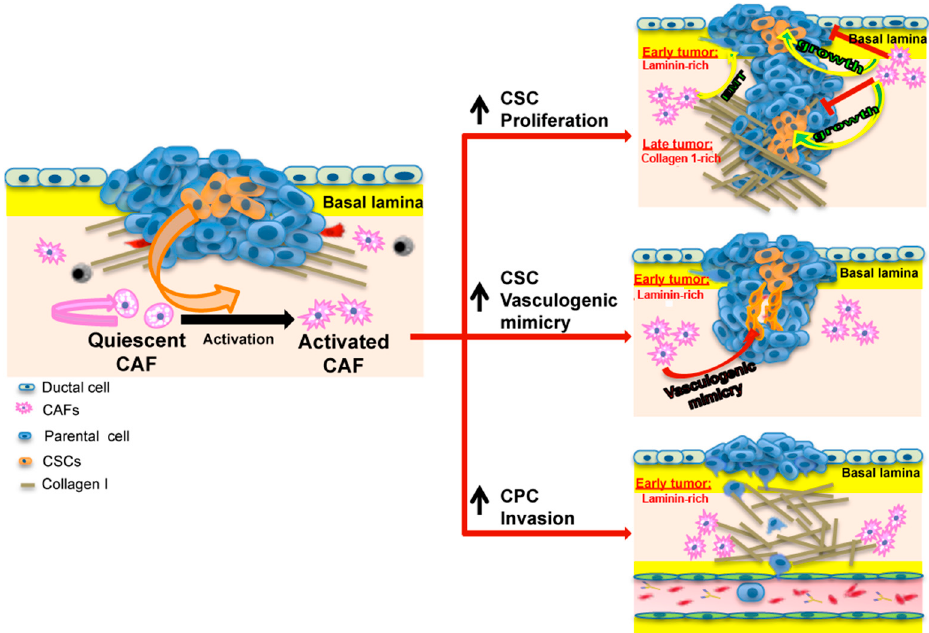
Figure 4. Model of Influence of the ECM composition on the CAF-dependent regulation of CPC and CSC plasticity. Matrigel induces the formation of autocrine loops in CSCs. Indeed, on Matrigel CSCs secrete a high amount of potent proangiogenic and growth factors (i.e., PDGF, MMP9, IL8, EGF, HGF, bFGF, ET-1) [5], which, via paracrine mechanisms, stimulate CAF growth [20], which in turn secrete factors that increase CSC growth/self-renewal and vasculogenic mimicry while decreasing CPC growth [24,28] but increasing CPC invasion [24–27]. This creates a vicious positive-feedback growth cycle between the CAFs and CSCs to increase the stemness of the tumor while exacerbating the aggressive angiogenesis phenotype of the CSCs and invasive phenotype of the CPCs.